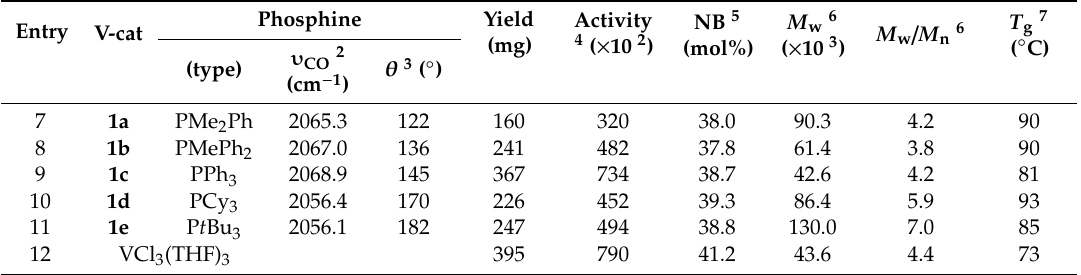
Table 2. Copolymerization of E / NB catalyzed by 1a – 1e in combination with Et 2 AlCl and ETA.